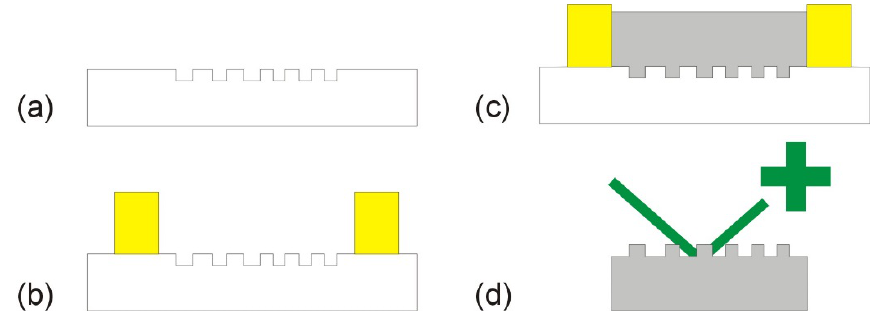
Figure 8. Process flow for the fabrication of parts with an integrated diffractive optical element (DOE) using CLR-LIGA technology: ( a ) The nanostructuration of DOE onto the substrate using standard micromachining; ( b ) micromechanical part definition by SU-8 photolithography onto the pre-structured substrate; ( c ) electroplating in photoresist template and on DOE; ( d ) removing of the substrate and photoresist to obtain parts with integrated DOE.